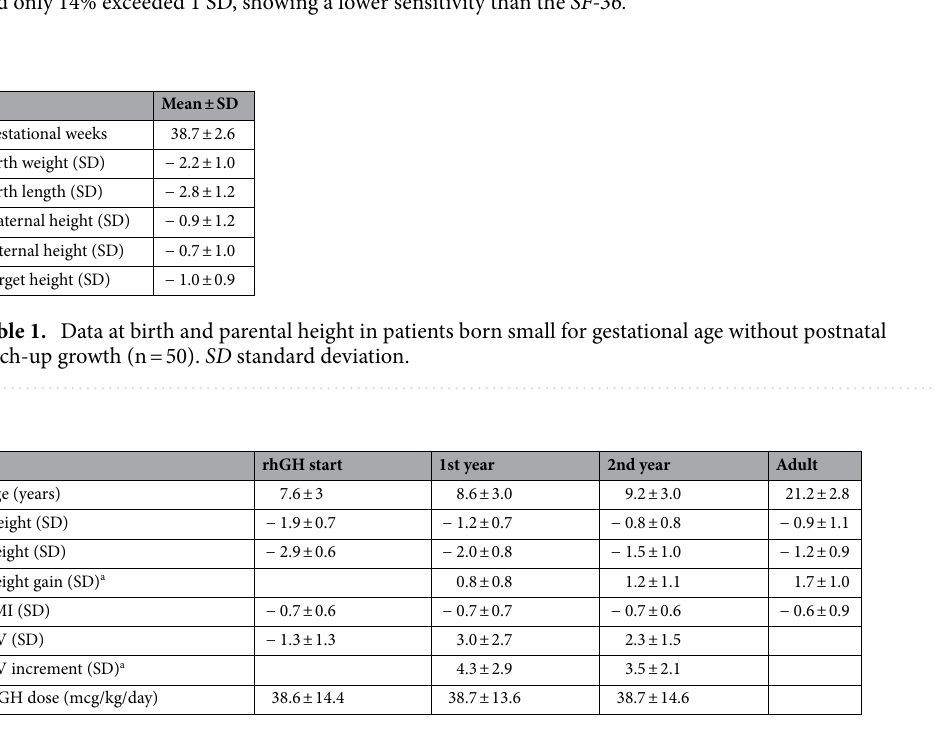
Table 2. Change in anthropometric parameters during recombinant human growth hormone (rhGH) treatment and adult height in subjects born small for gestational age without catch-up growth (n = 50). BMI body mass index, HV height velocity, SD standard deviation. Values are expressed as mean ± SD. a From the start of rhGH